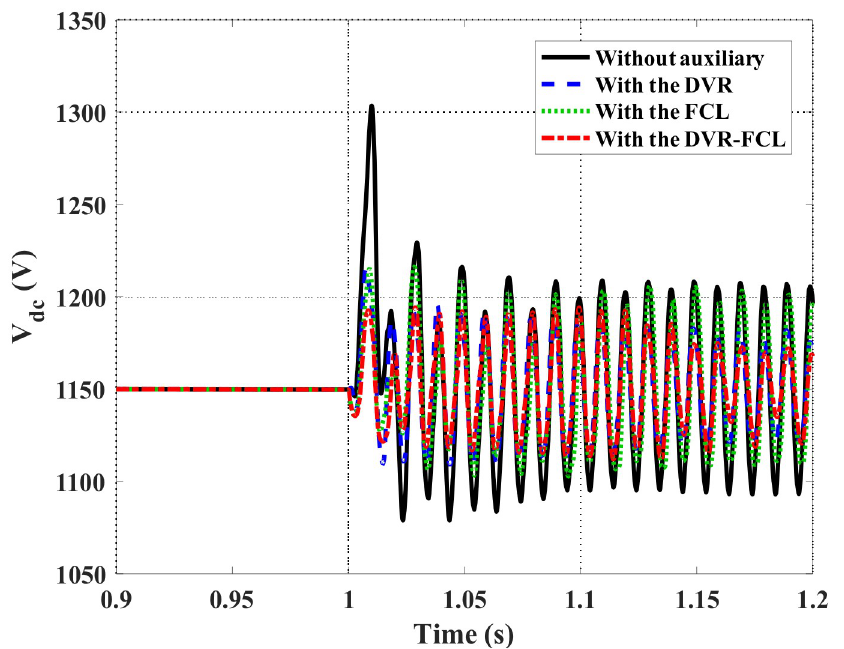
Fig 19. DC-link voltage of the DFIG subject to the asymmetrical fault.